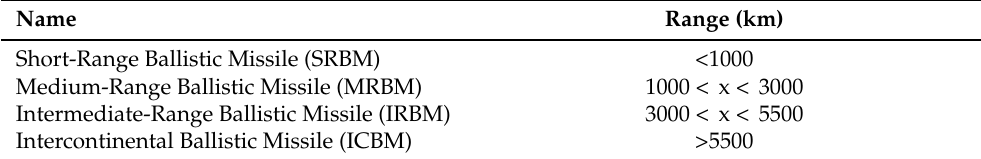
Table 1. Designations of ballistic missile according to the maximum range [9,10].